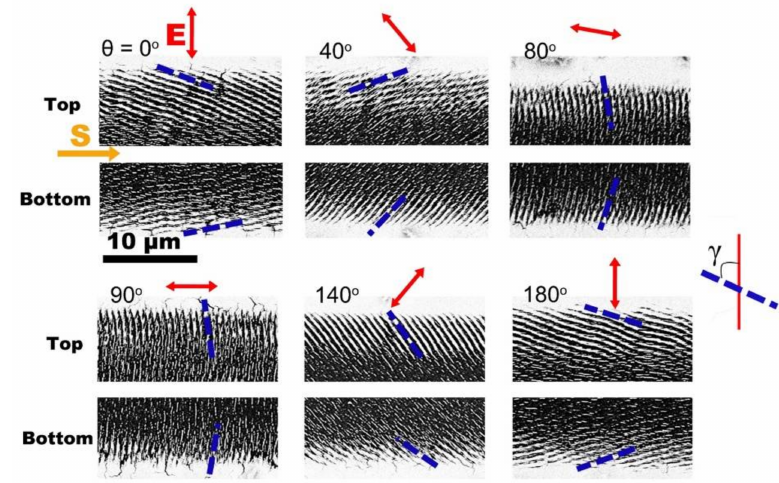
Figure 3. Slantwise-oriented ripple structures on two lateral edge regions (Top and Bottom) of the laser-scanned area on Cr film surfaces by different linear polarizations of single-beam femtosecond laser pulses. The angle θ on the upper-left corner of each image represents the direction of the laser polarization. The blue dash lines identify the orientations of the ripple structures. The angle of γ indicates an intersection angle between the ripple orientation and the laser polarization direction of θ = 0 ◦ . The scale bar is applied to all images in this